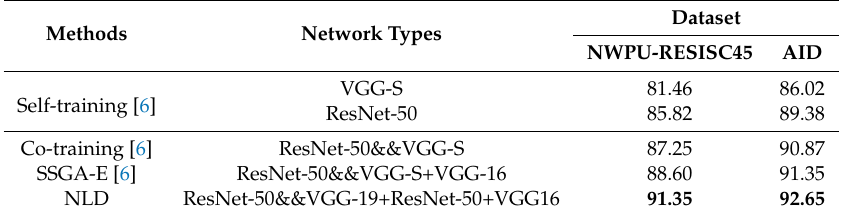
Table 9. Comparison with results on the NWPU-RESISC45 and AID test set reported by Han et al. [6].